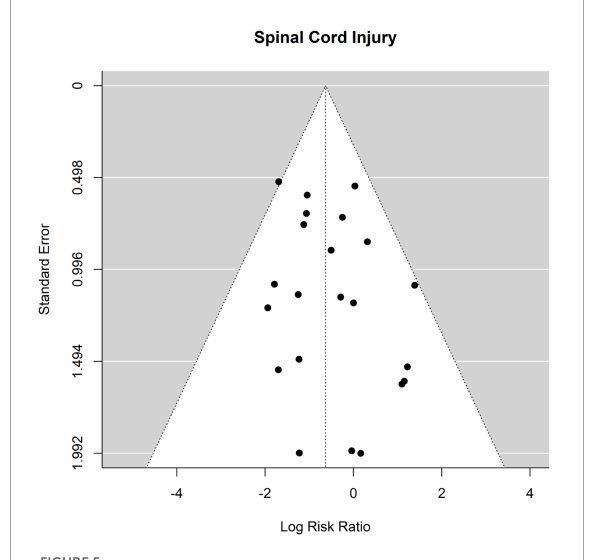
FIGURE5 Relative risk of spinal cord injury (SCI) and hemiplegia/paraplegia in patients undergoing aortic interventions with conventional elephant trunk (ET) vs. frozen elephant trunk (FET). Funnel plot.